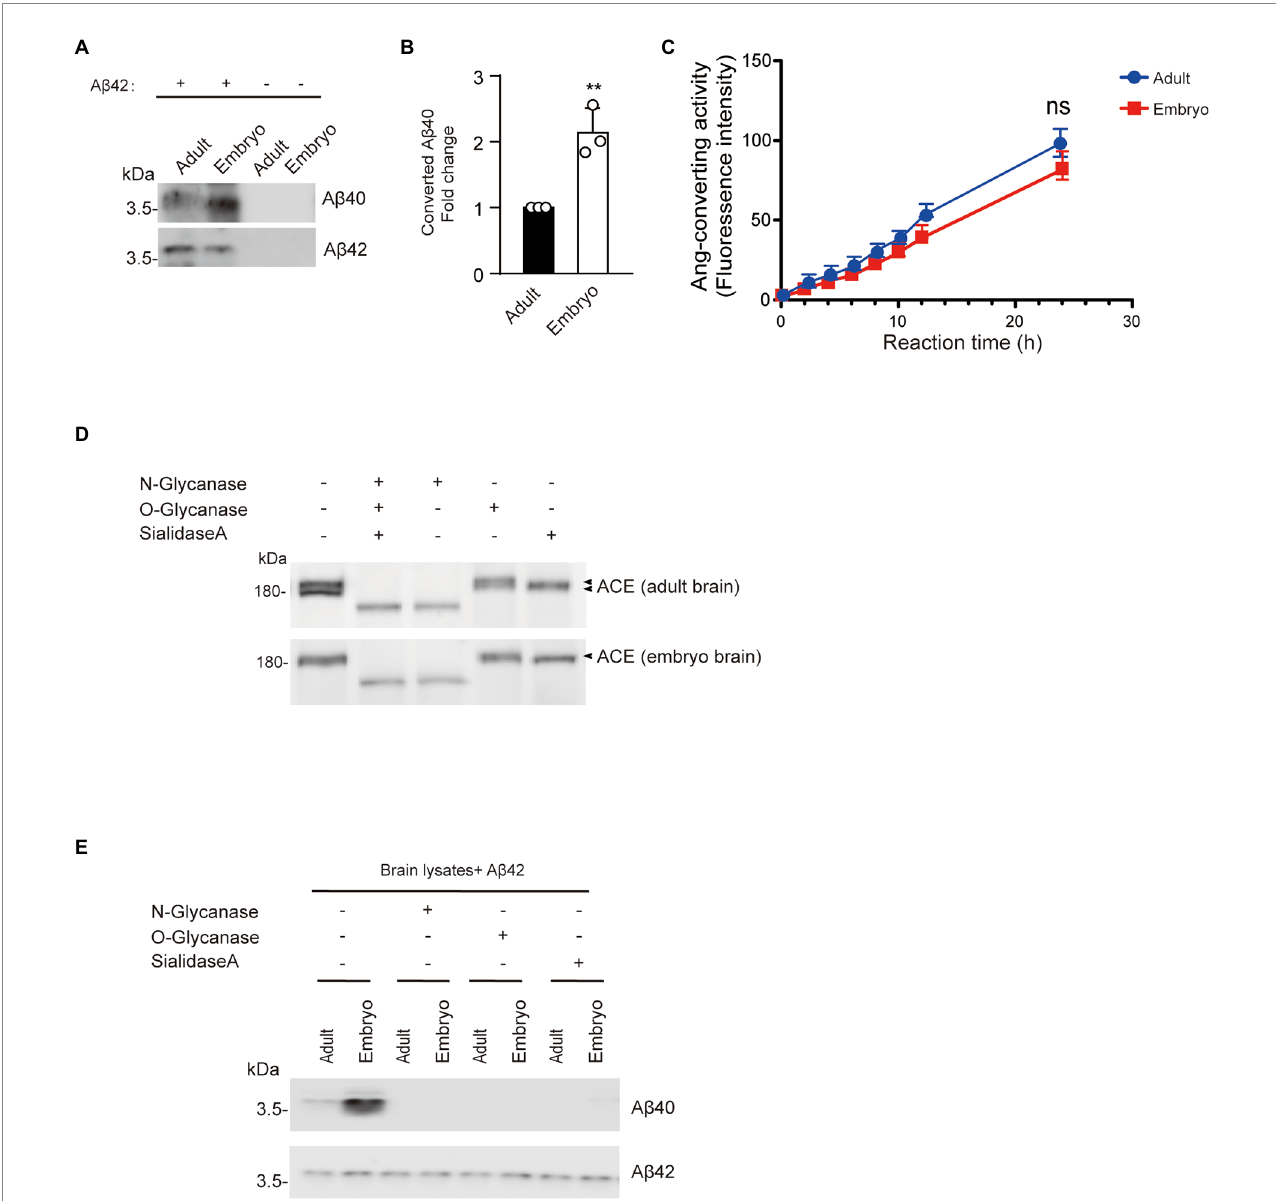
FIGURE 7 A β 42-to-A β 40-converting activity in adult mouse brain cortex is lower than that in embryonic brain cortex. (A) Synthetic A β 42 protein (40 μ M) was incubated with 20 μ g of cortex lysate from 17-day-old embryos or 3-month-old mice. A β 40 and A β 42 were detected by Western blotting. (B) Quantification of A β 40 converted from A β 42. Embryo cortex exhibited higher A β 42-to-A β 40-converting activity than adult cortex. Values represent the mean ± SEM; n = 3; ** p < 0.001, by unpaired two-tailed Student’s t test. (C) Ang-converting activity was measured by incubating 2 μ g of total protein of cortex lysate from 17-day-old embryos or 3-month-old mice with the synthetic o-aminobenzoyl peptide substrate for 24 h at 37 ° C. Values represent the mean ± SD; n = 3; NS, not significant, by unpaired two-tailed Student’s t test. (D) Western blots of 20 μ g of total protein of cortex lysate from 17-day-old embryos or 3-month-old mice were probed with a polyclonal anti-ACE antibody. (E) 20 μ g protein of cortex lysate from 17-day-old embryos or 3-month-old mice were de- glycosylated and incubated with synthetic A β 42. A β 40 and A β 42 were detected by Western